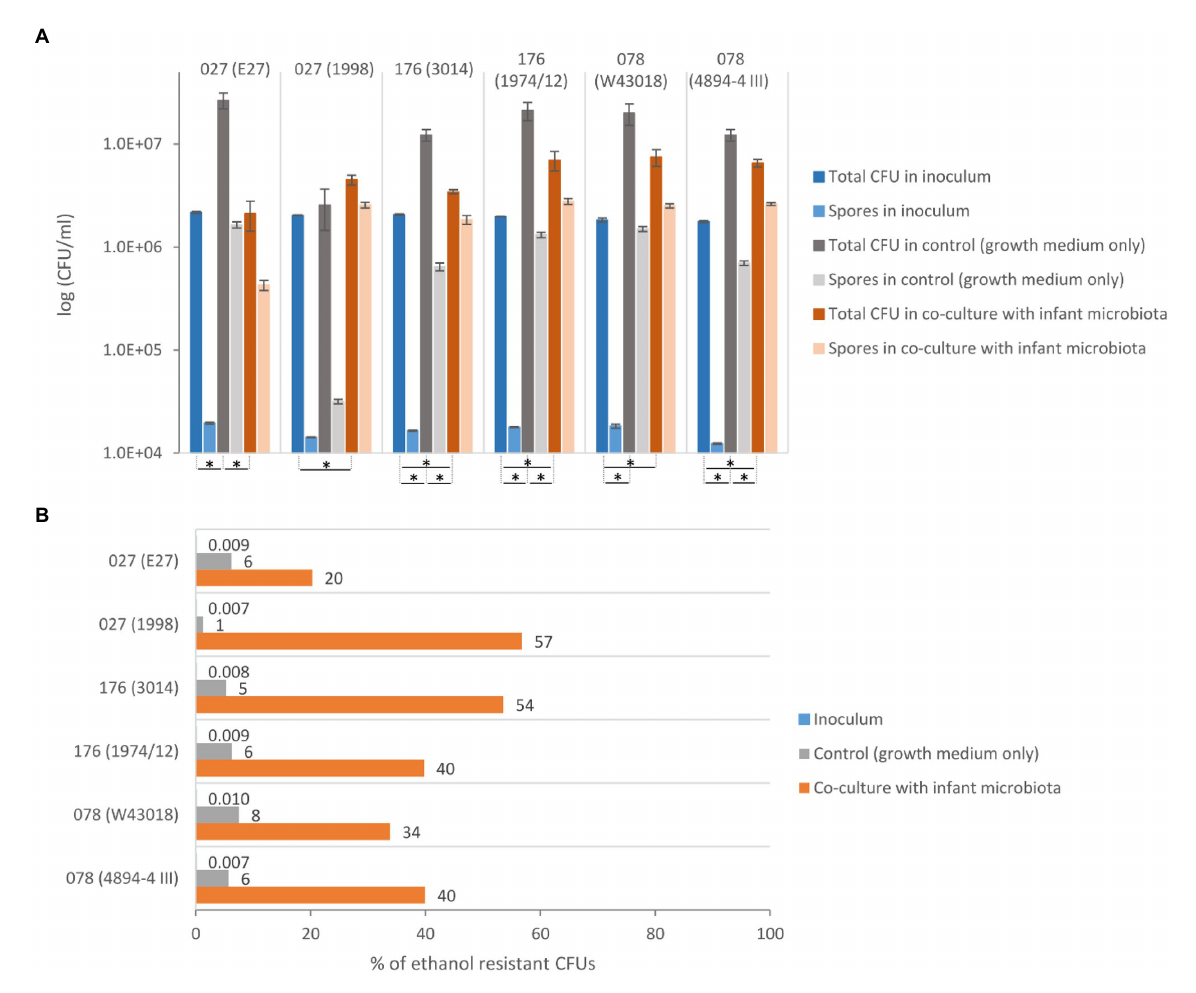
FIGURE 1 Growth and sporulation of C. difficile in co-culture with children fecal microbiota. (A) The total CFU (vegetative cells and spores) and ethanol resistant CFU (spores) with the corresponding standard deviation for C. difficile ribotypes 027, 176 and 078 strains. *Statistically significant difference (one-way ANOVA: p < 0.05). (B) The percentage of C. difficile spores detected as ethanol resistant CFUs in proportion to the total CFU for ribotypes 027, 176 and 078